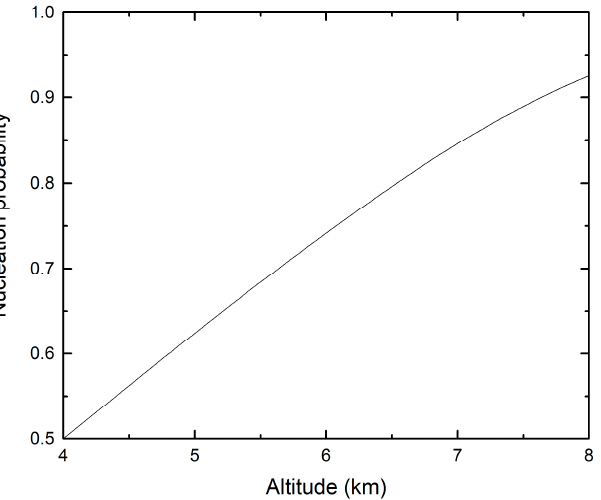
Figure 8. Ice Nucleation probability of 140 bacterial cells distribution [40] at different altitudes.